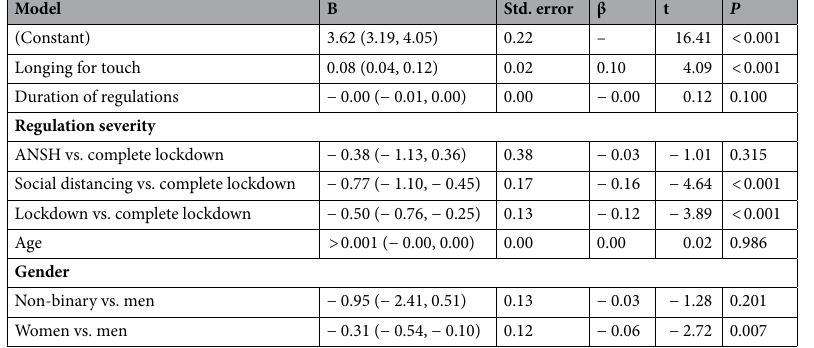
Table 5. Regression coefficients wit perceived pleasantness of CT non-optimal touch observation as outcome measure. Multiple linear regression model (95% CI in parentheses). ANSH advice to not shake